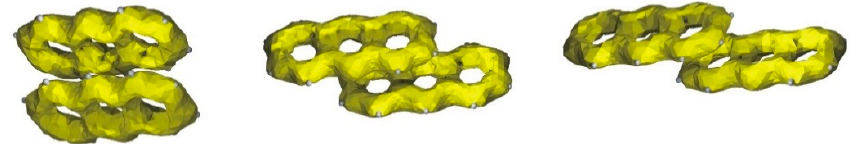
Figure 9. ACID surfaces for different arrangements of the stacking acridine molecules.